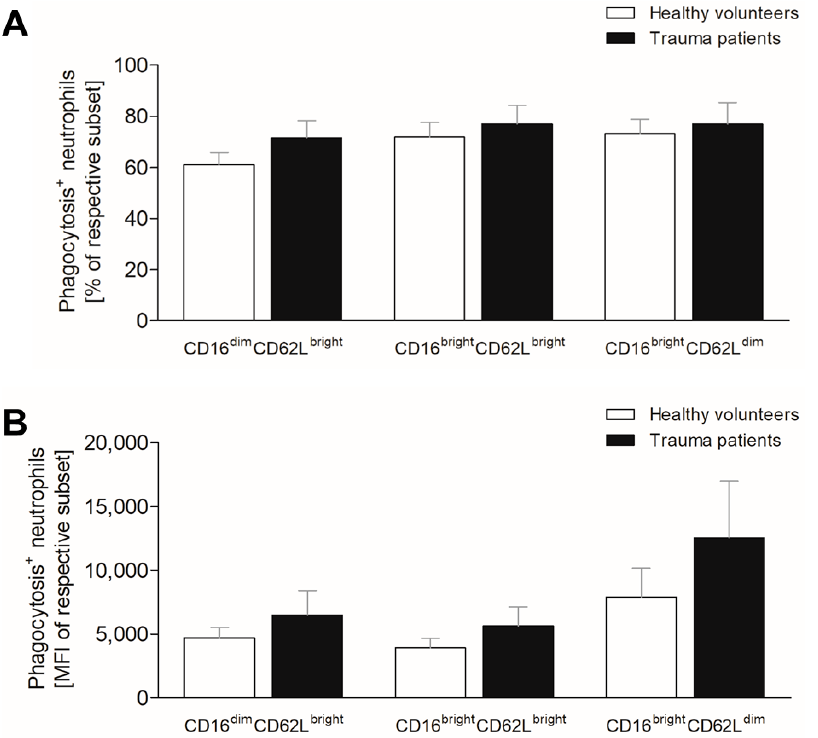
Figure 3. Impact of severe traumatic injury on phagocytic capacity of neutrophil subsets. The ( A ) percentage and ( B ) mean intensity of phagocytosis positive CD16 dim CD62L bright (immature), CD16 bright CD62L bright (mature) and CD16 bright CD62L low (CD62L dim ) neutrophils were determined in healthy subjects (white bars) and severely injured patients (black bars) within 12 h postinjury. Data are presented as mean ± standard error of the mean.